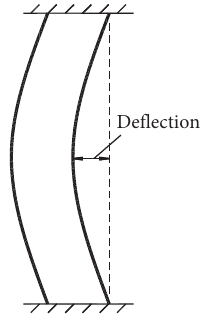
Figure 18: Schematic view of column deflection.